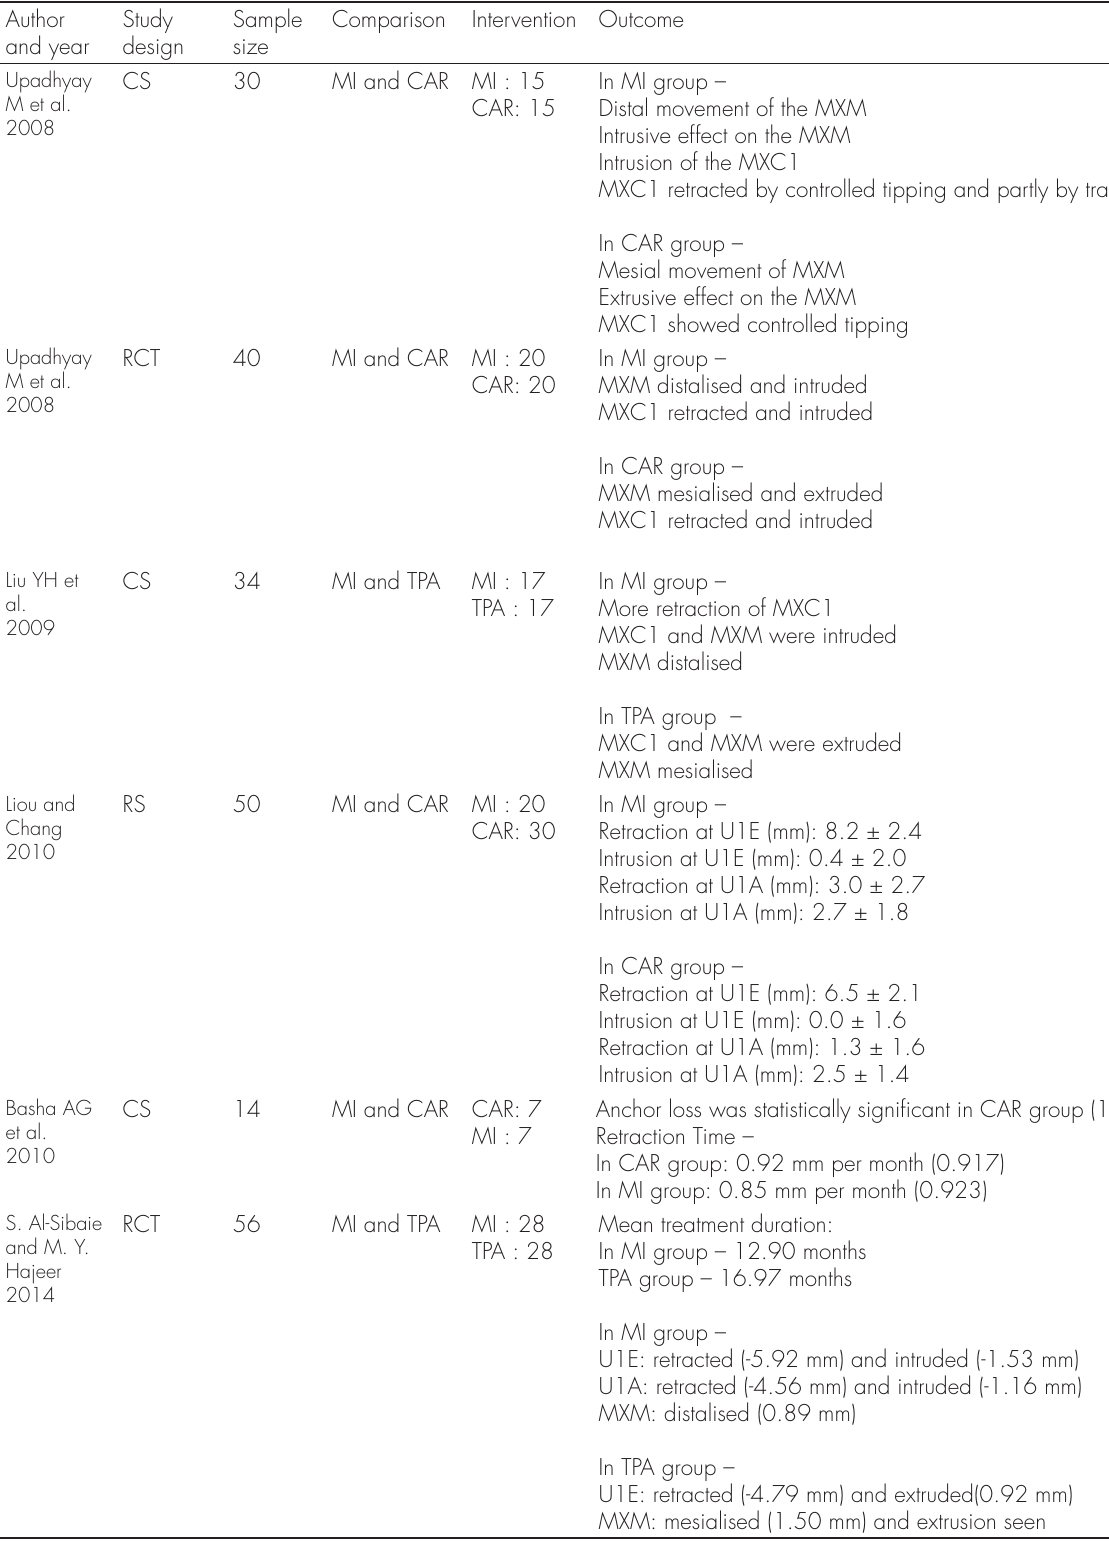
Table VII. Mini-implants compared with intra oral anchorage